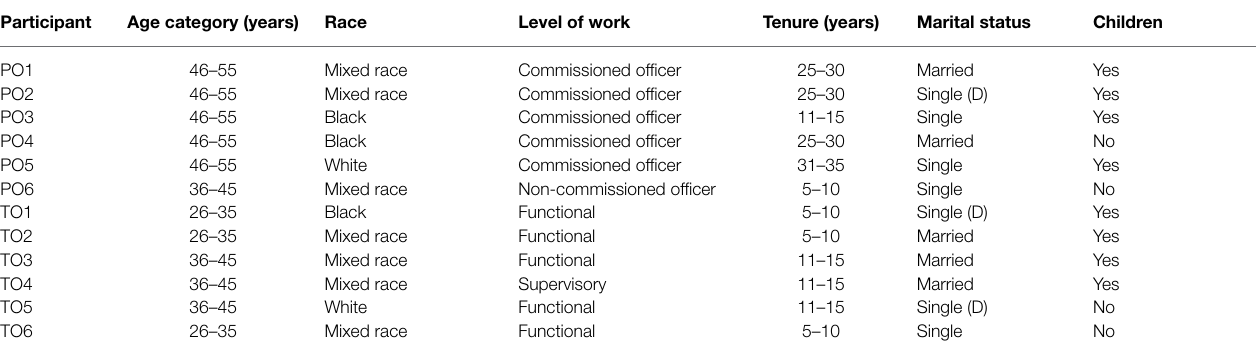
TABLE 1 | Descriptive profile of the research participants.